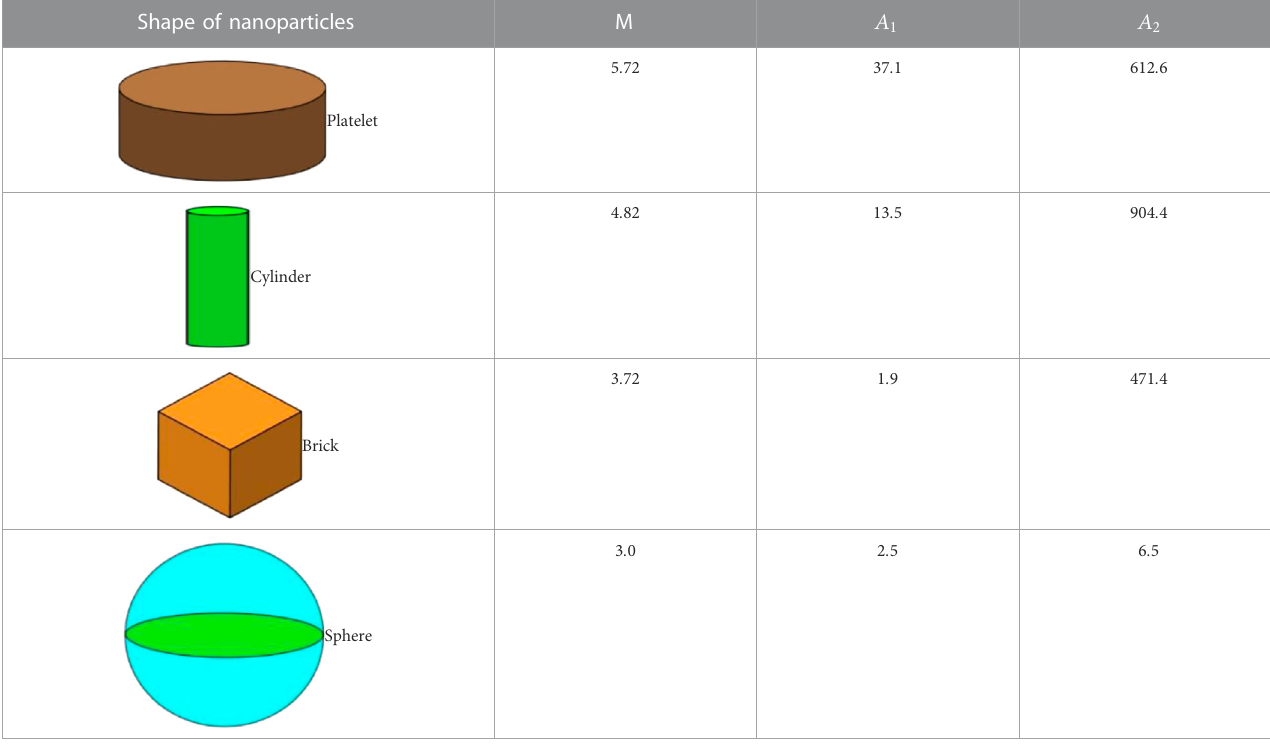
TABLE 2 Shapes of nanoparticles associated with size (Naseem et al., 2021). Shape of nanoparticles